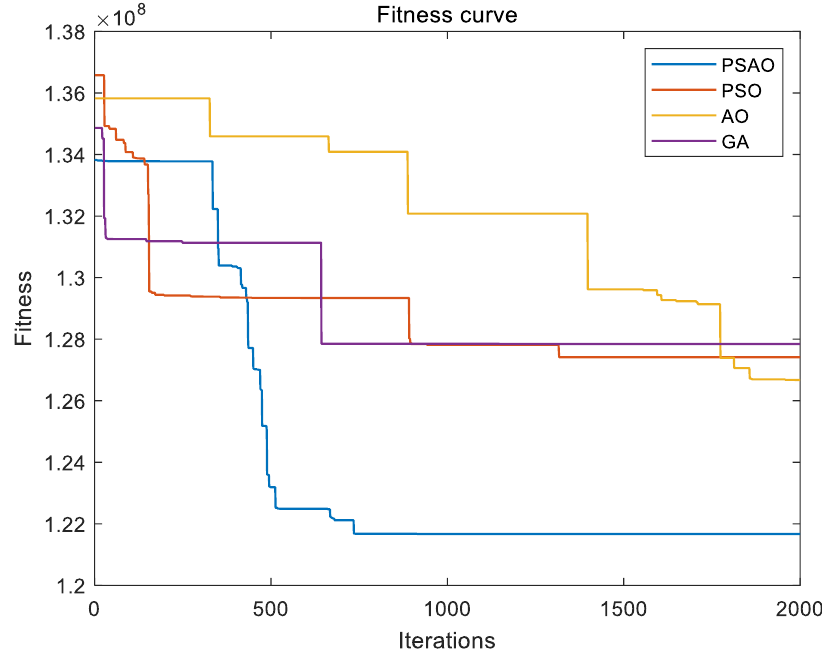
Figure 8. Fitness curve (variable substation location).